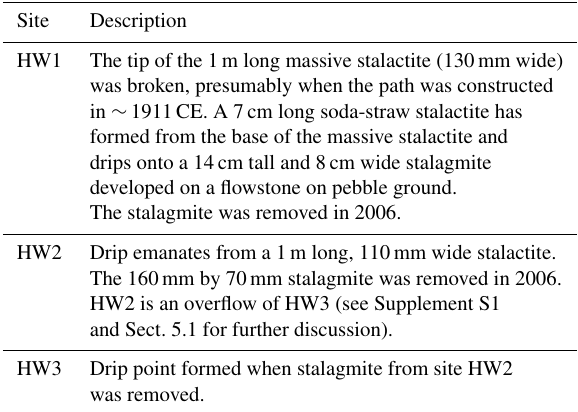
Table 1. Summary of the drip-point characteristics for the monitor- ing